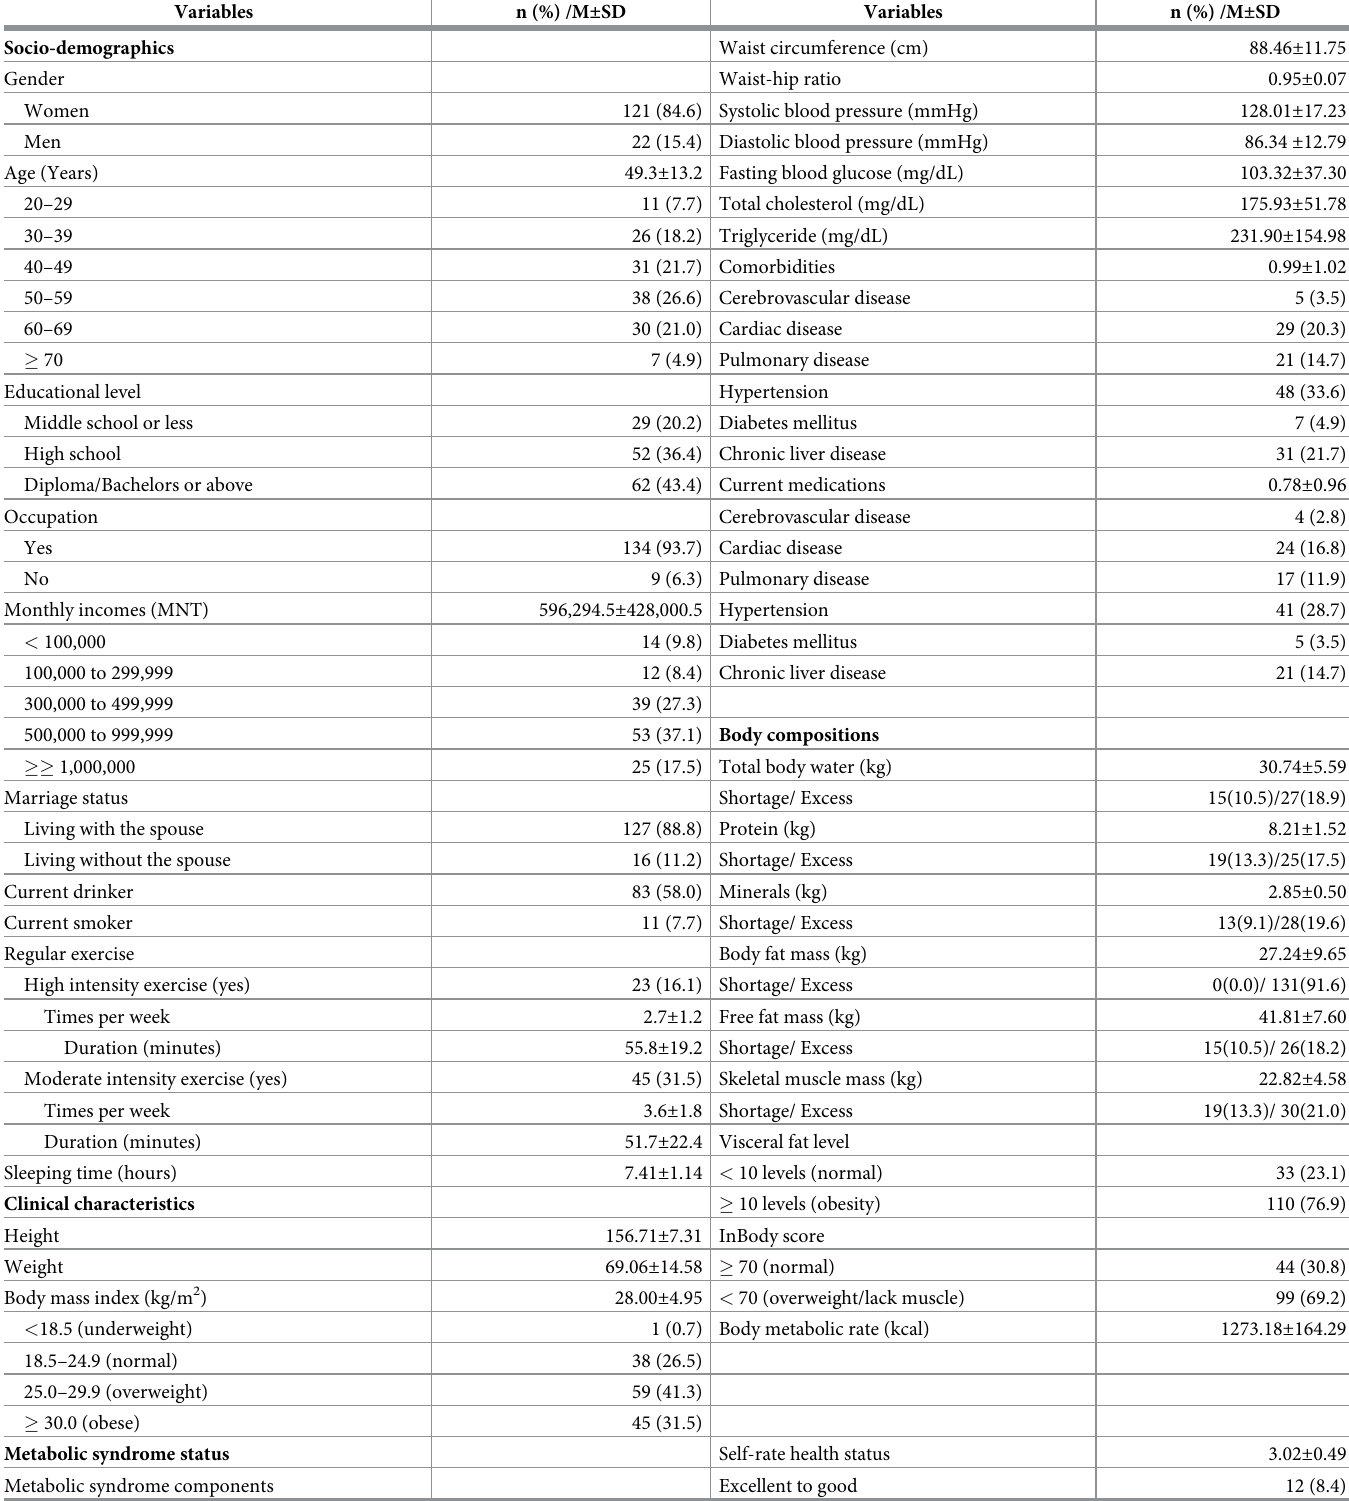
Table 1. Descriptive statistics of study subjects ( N =